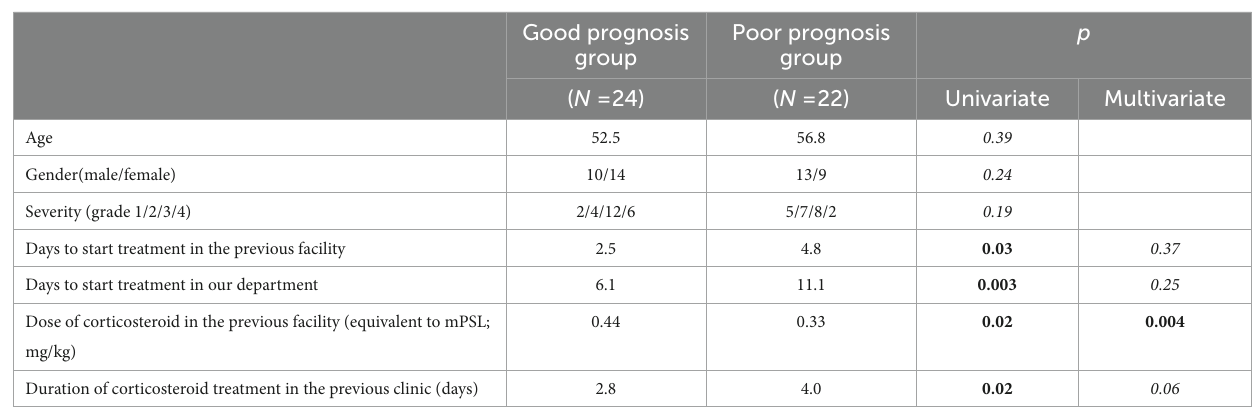
TABLE 4 Prognostic factors in the repetitive-treatment